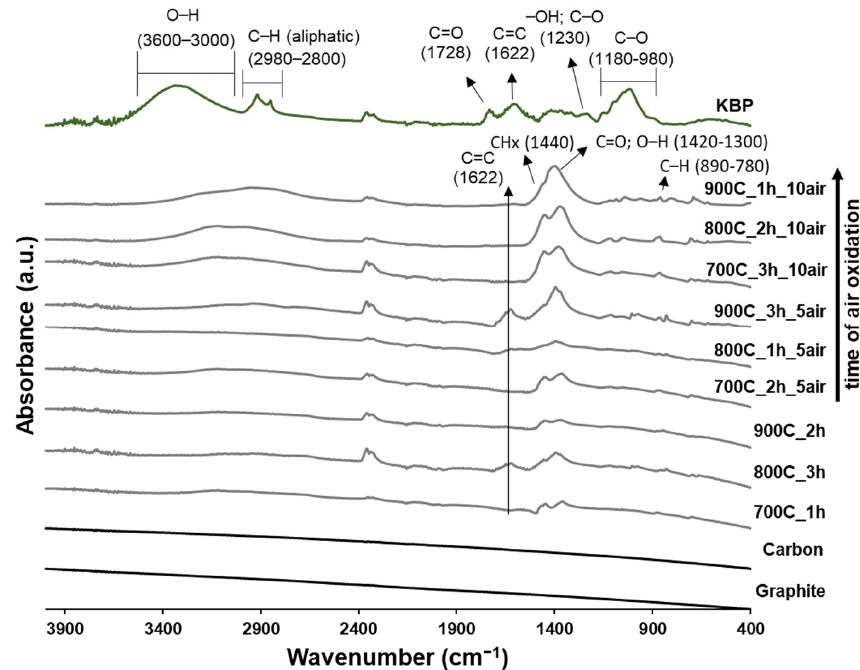
Figure 2. ATR–FTIR spectra of biomass (kidney-bean pods, KBPs) and the biochars resulting from pyrolysis using different time, temperature, and air oxidation conditions. The spectra of carbon and graphite are displayed as a reference.